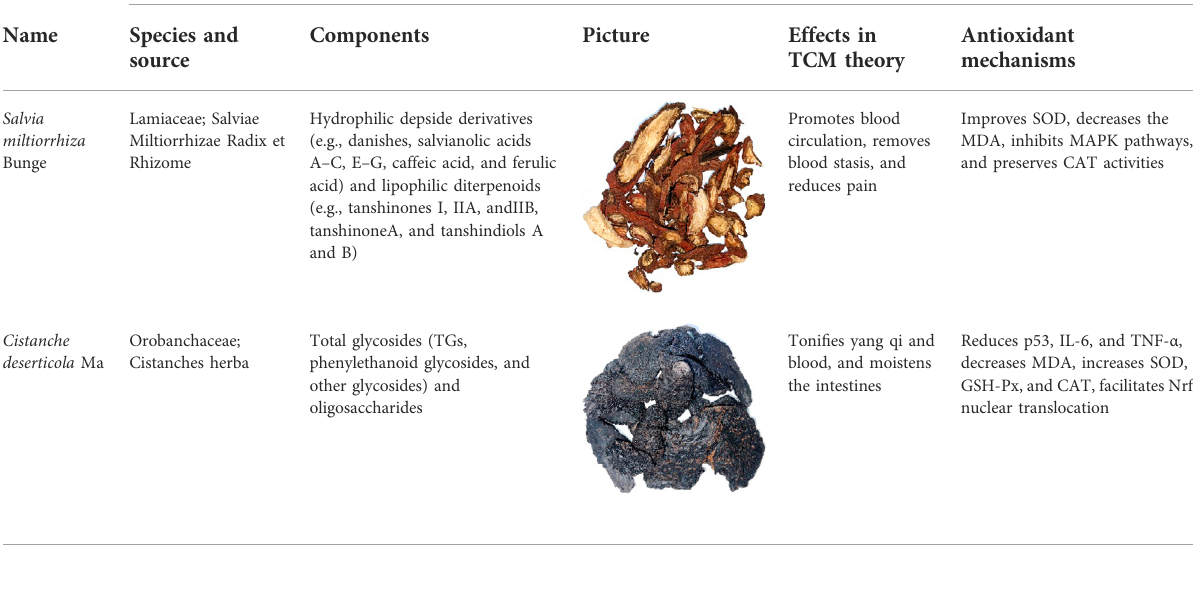
TABLE 4 Therapeutic intervention with traditional